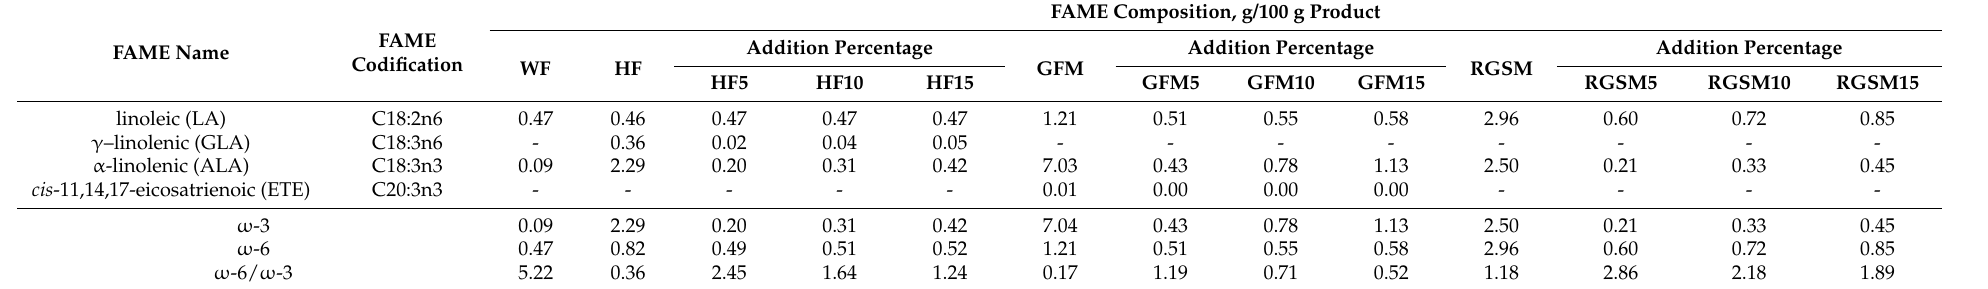
Table 6. Influence of different percentages of hemp flour, golden flax meals, and red grape seeds meals addition on the ω -3 and ω -6 fatty acids of wheat flour.